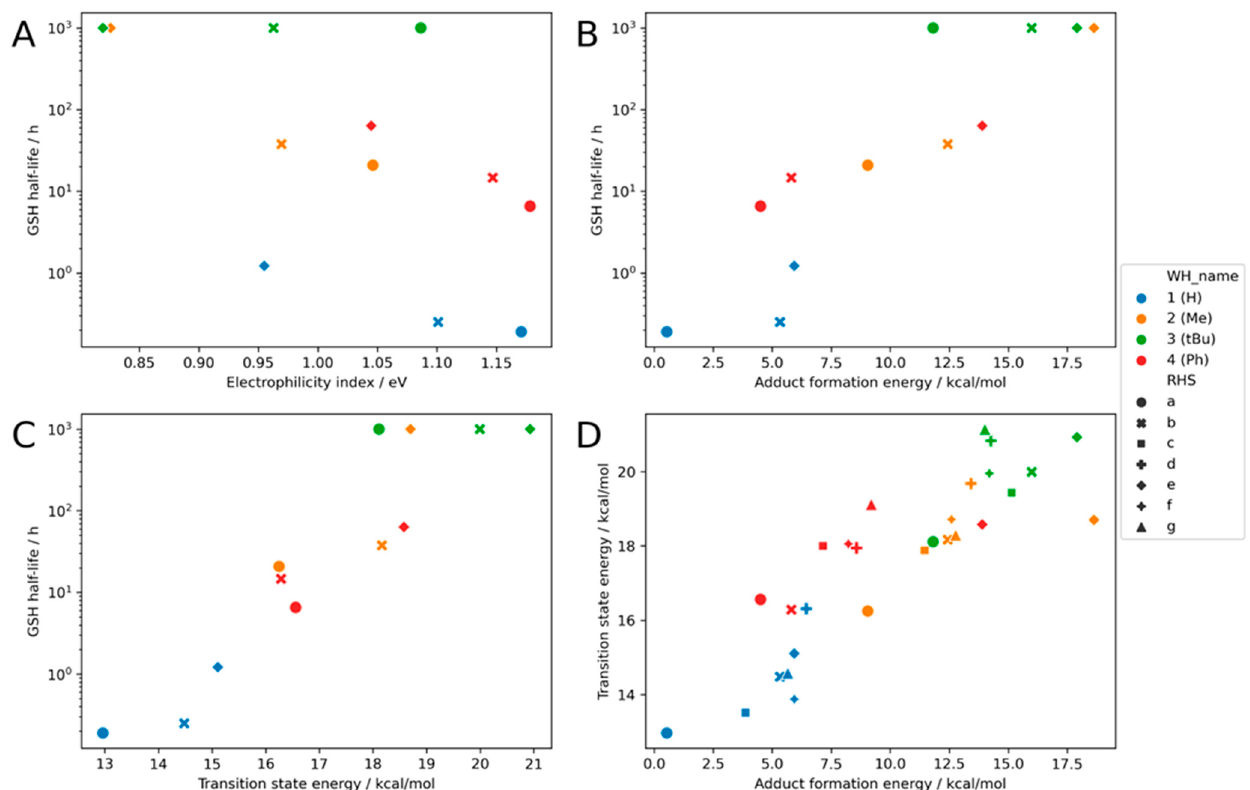
Figure 4. Calculation for the benchmark set with the combination of different warheads and scaffolds: ( A ) the result of the electrophilicity index (R 2 : 0.38), ( B ) the result of the adduct formation energy (R 2 : 0.81), ( C ) the result for the transition state energy (R 2 : 0.86), and ( D ) the correlation between transition state energy and adduct formation energy. (R 2 : 0.76, MAE: 0.91 kcal/mol). Four exemplary structures are shown.